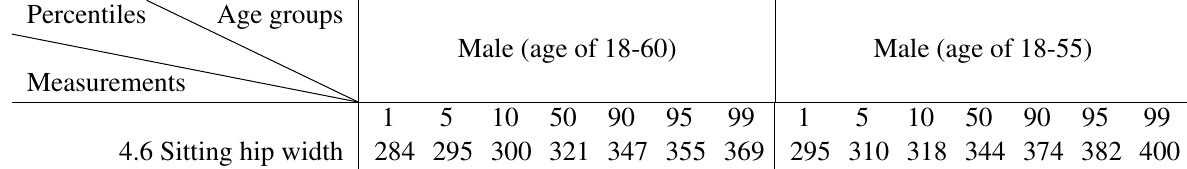
Table 2 Horizontal dimension of human body(part). (unit: mm)